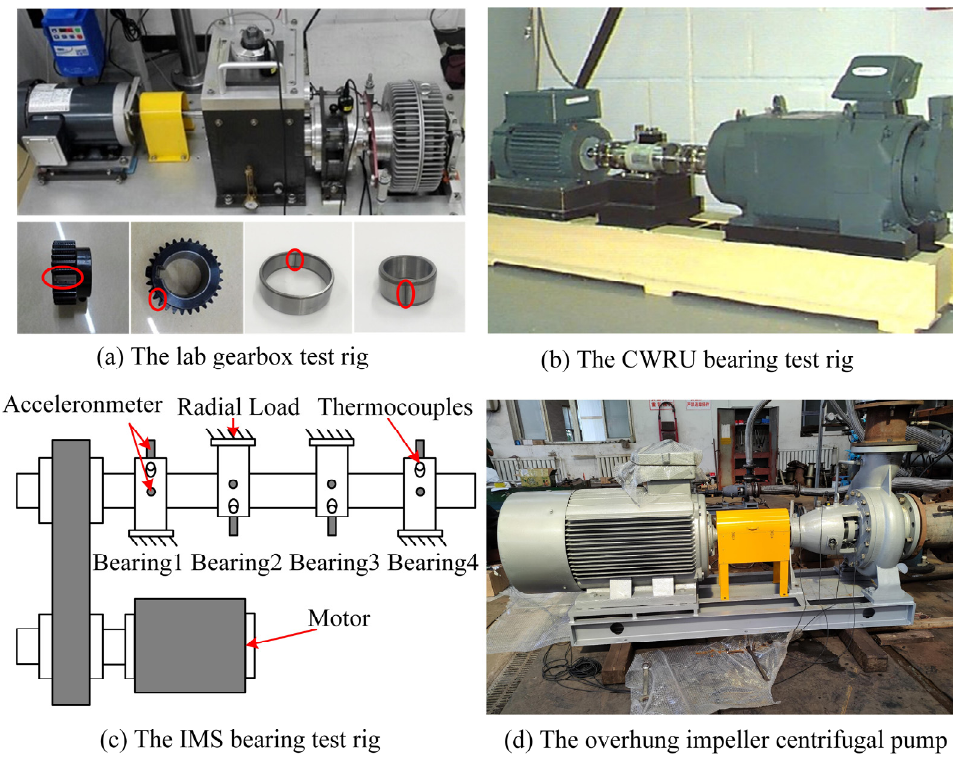
Figure 4. The test rigs. ( a ) The lab gearbox test rig, ( b ) The CWRU bearing test rig, ( c ) The IMS bearing test rig, ( d ) The overhung impeller centrifugal pump